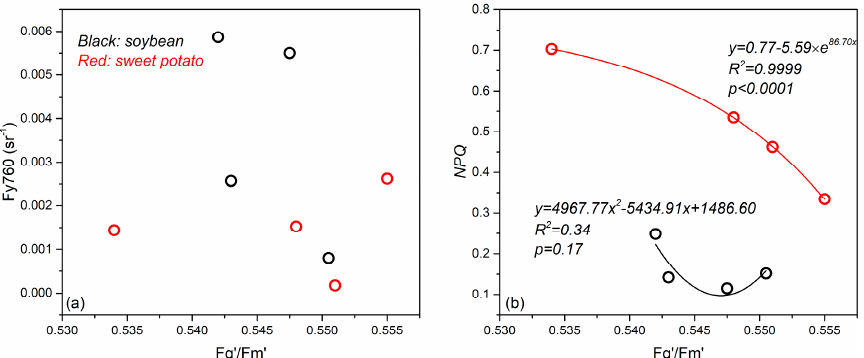
Figure 4. Diurnal patterns of ( a ) and ( b ) Fy760 accompanied by the absorbed photosynthetically active radiation (APAR), ( c ) and ( d ) PSII operating e ffi ciency ( F (cid:48) q / F (cid:48) m ) accompanied by NPQ in soybean (upper panel) and sweet potato (lower panel). The values of APAR in left column was calculated based on Equation (2).